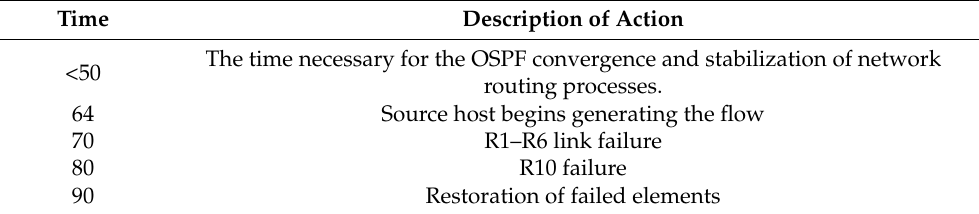
Table 8. Description of the comprehensive simulation